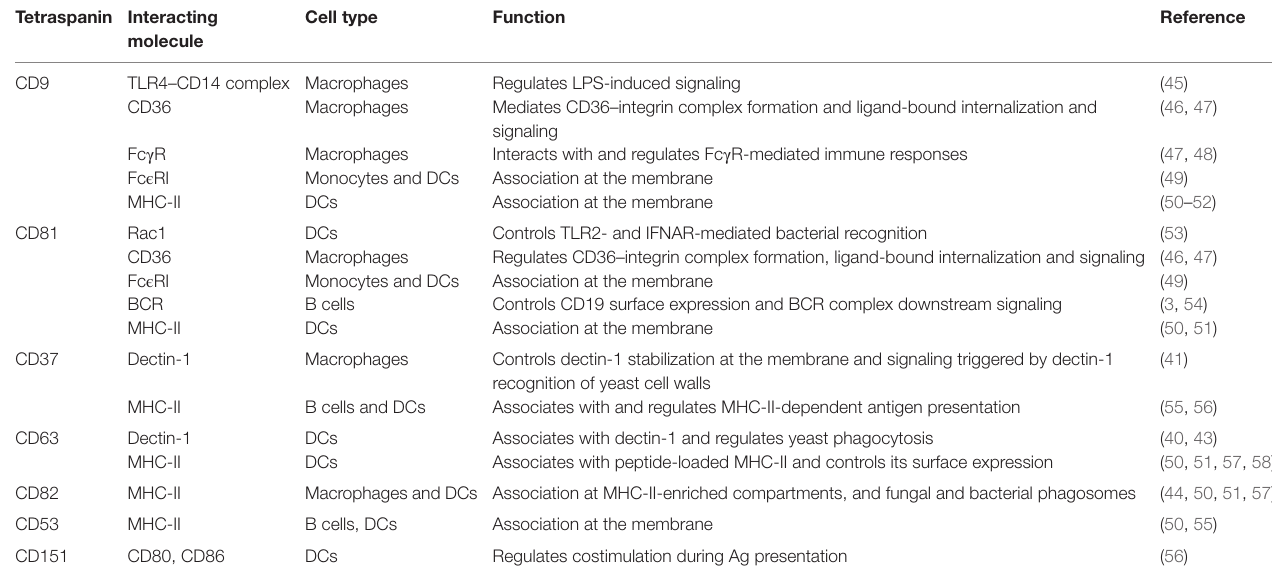
TABLe 1 | Tetraspanin associations in pathogen-recognition receptors and APC functions. Tetraspanin interacting